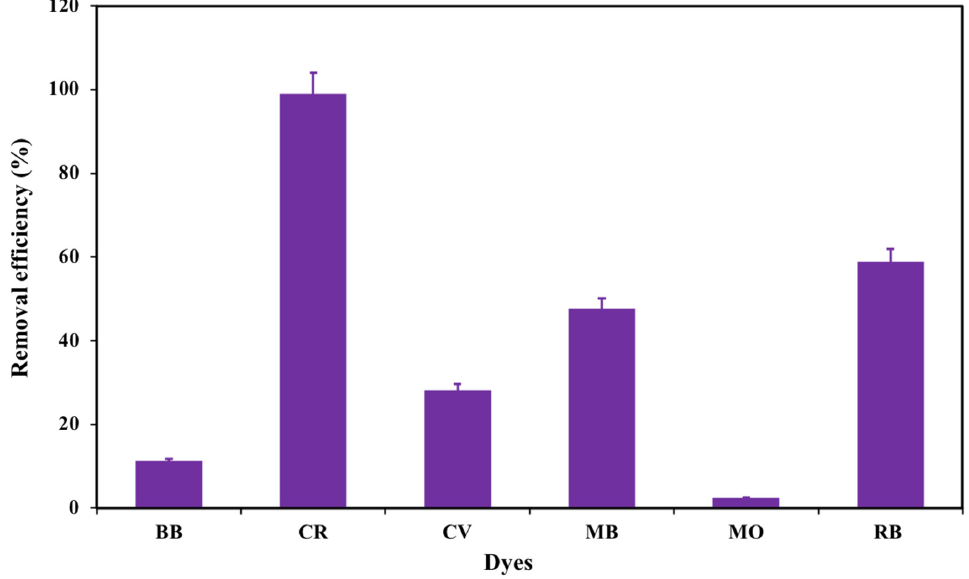
Figure 5. Selectivity studies of CS-HAP-CeO 2 heterostructure toward different dyes.